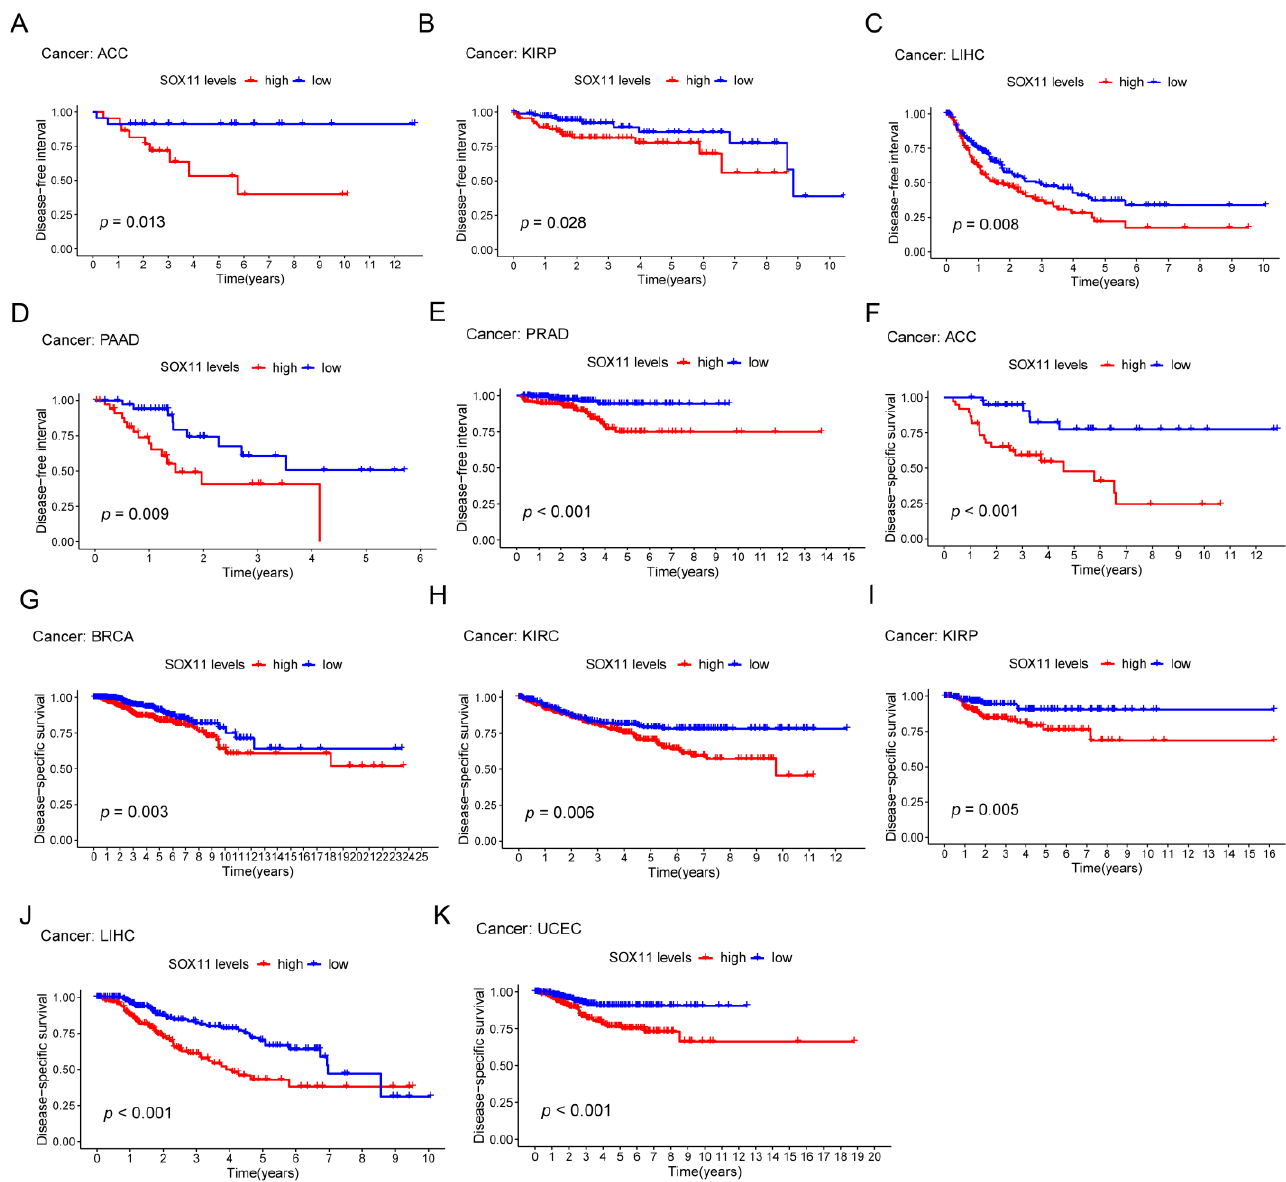
line indicates a high SOX11 expression group, and the blue line indicates a low SOX11 expression group.